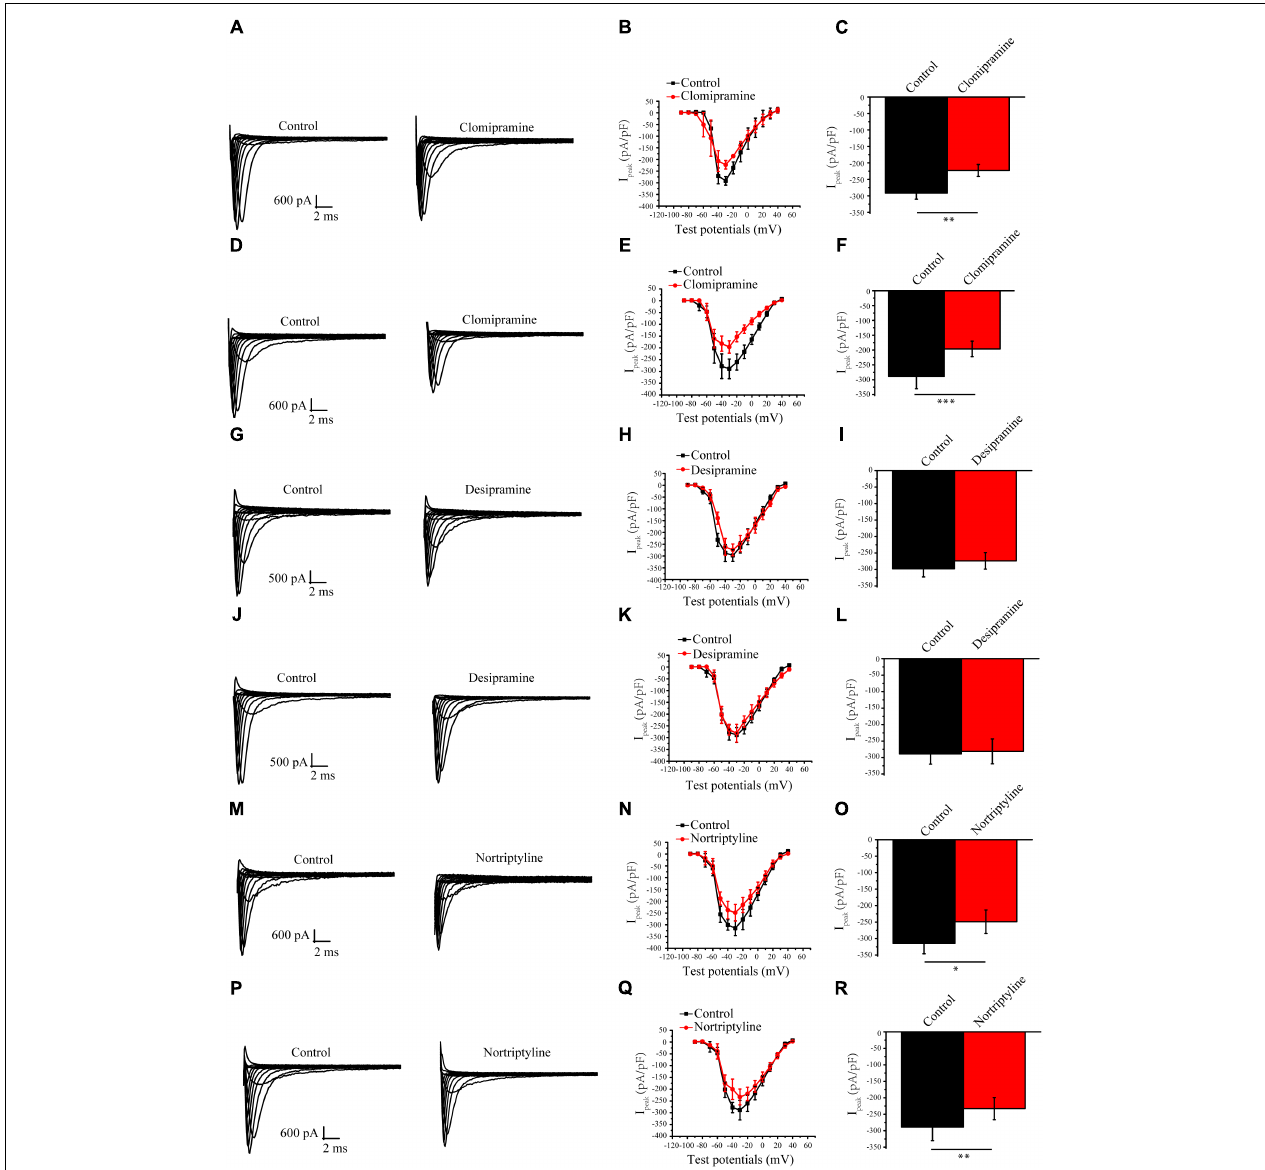
FIGURE 6 | Effect of other antidepressants on Nav1.5 currents. (A) Representative I Na current traces recorded from cells under control conditions and acute clomipramine treatments of (B,C) I-V curves and analysis of the peak I Na densities for the acute effect of clomipramine. (D) Representative I Na current traces recorded from cells with long-term treatments of clomipramine. (E,F) I-V curves and peak I Na densities of cells with long-term treatmentsn of clomipramine. (G–I) Representative I Na in cells with acute desipramine treatments. (J–L) Representative I Na in cells with long-term treatments of desipramine. (M–R) Representative I Na in cells with acute and long-term treatments of nortriptyline. ∗ P < 0.05, ∗∗ P <